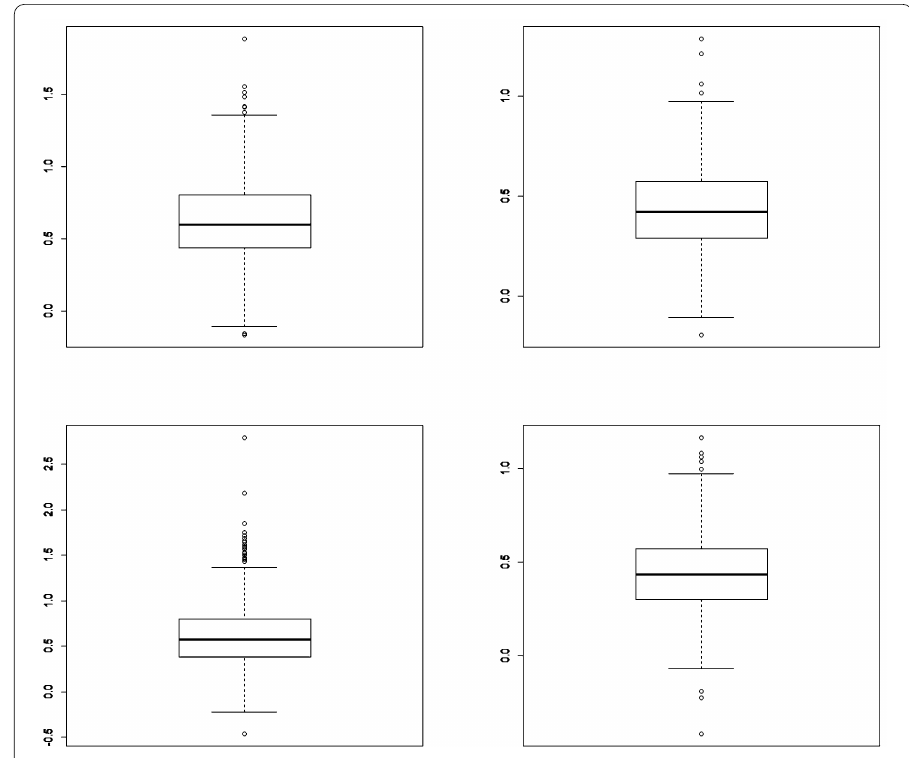
Figure 2 The two figures in first line are the Boxplot of estimated parameter α 1 , α 2 , respectively, for Model II with λ = 1. The two figures in second line are the Boxplot of estimated parameter p 1 , p 2 , respectively, for Model II with λ = 1. All Boxplots are obtained with sample size n = 500